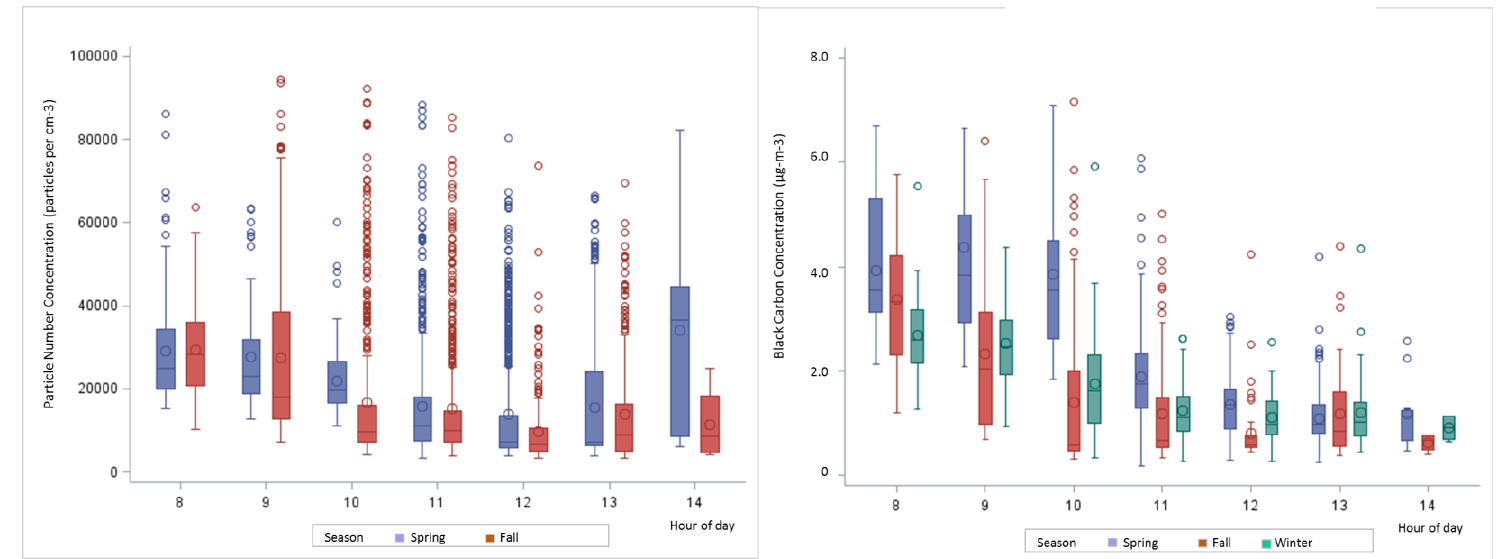
Figure 4. Pollutant concentrations according to hour of day and season.